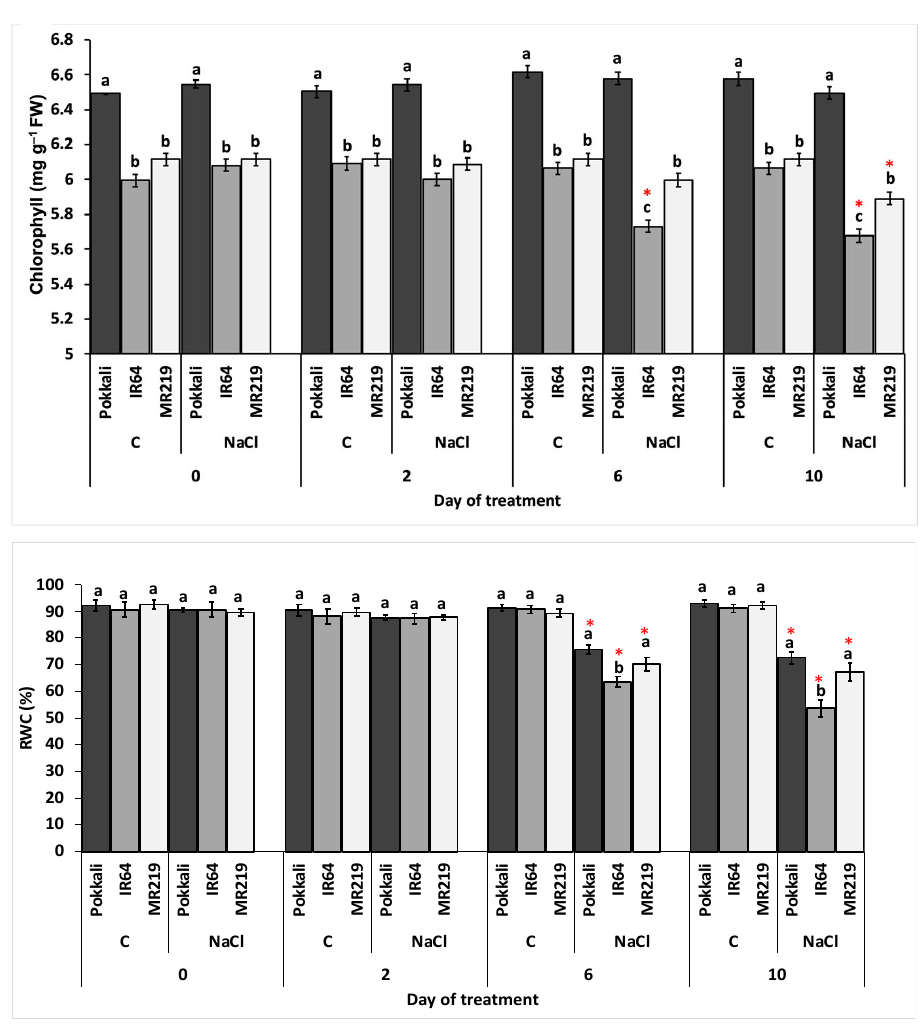
Figure 3. Salinity effect on fifth-leaf chlorophyll and the relative water content of 15 leaf discs for each variety at four different time points. The small letter at the top of the bar indicates significant differences between varieties at the same time point, whereas (*) indicates that there are significant differences in a variety between control and salinity-treated plants using the DNMRT analytical method with a p -value of 0.05. Error bar = Standard deviations (SD) of the means.